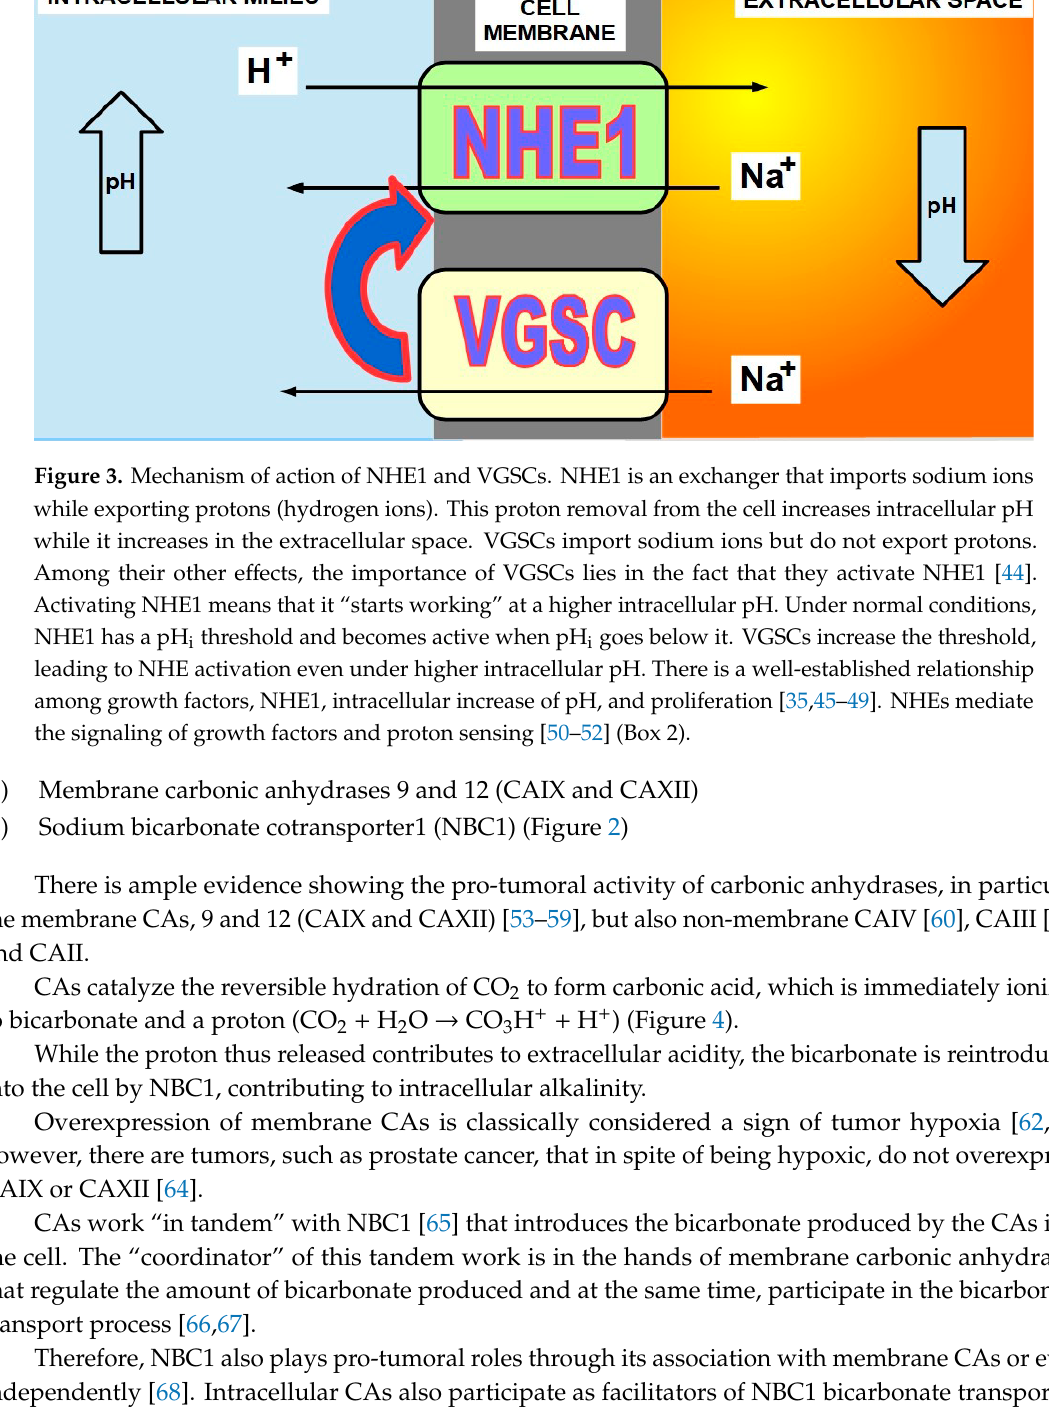
Figure 2. Mechanism of pH threshold modification of NHE1.